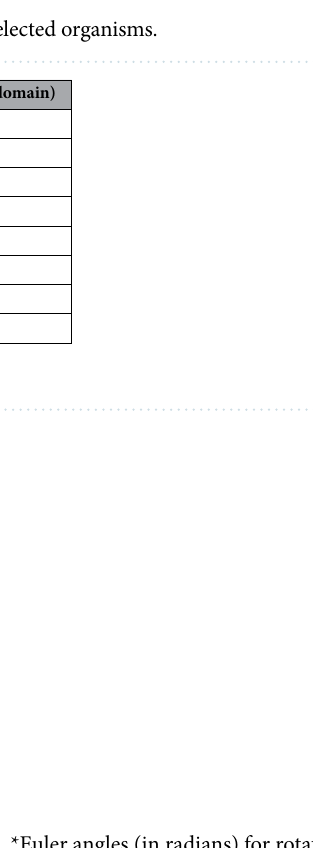
Table 2. Docking energy values of docked complexes using ZDOCK. *Euler angles (in radians) for rotating the (death domain-MADD) while grid positions describing the translation of the death domain-MADD concerning its starting